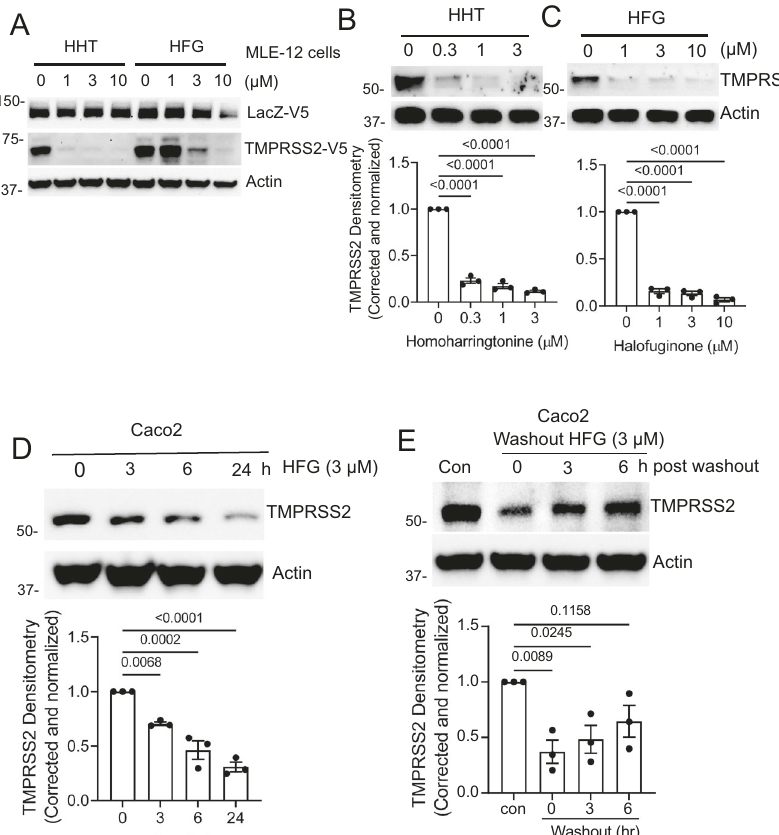
Fig. 4 Homoharringtonine and halofuginone potently reduce TMPRSS2 protein levels. A Immunoblot data from MLE-12 cells co-expressing LacZ-V5 and TMPRSS2-V5 treated with homoharringtonine (HHT) or halofuginone (HFG) at the indicated concentrations for 18 h. B , C Immunoblot analysis of endogenous TMPRSS2 protein level in Caco-2 cells treated for 18 h with HHT ( B ) or HFG ( C ). TMPRSS2 densitometry is shown, data are mean ± SEM ( n = 3 biologically independent samples). D Time-course treatment of HFG-treated Caco-2 cells (3 µ M). TMPRSS2 densitometry is shown, data are mean ± SEM ( n = 3 biologically independent samples). E Immunoblot analysis of Caco-2 cells treated with HFG for 18 h prior to removing the drug, adding fresh media, and then analyzing the protein recovery time course. (All TMPRSS2 densitometry that is shown represents mean ± SEM ( n = 3 biologically independent samples). Actin is shown as a loading control. P -values are shown for comparisons to 0 time point or control, or as indicated by one-way ANOVA with Dunnett ’ s test of multiple comparisons ( B – E